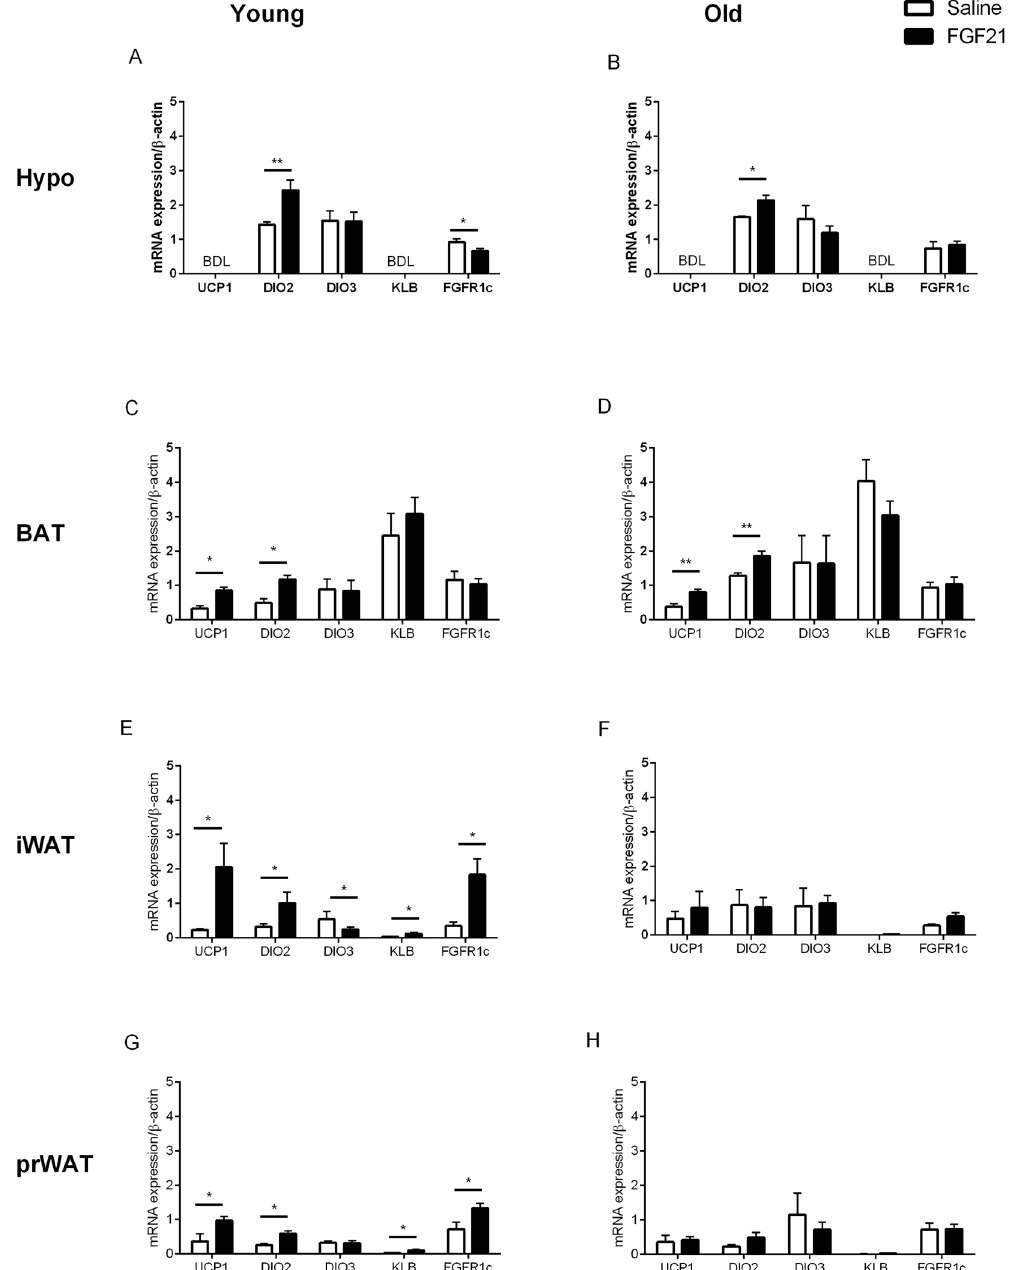
Figure 5. Treatment with FGF21 increases thermogenic genes in the hypothalamus and iBAT in young and aged Siberian hamsters, whilst the effects of treatment are lost in iWAT and prWAT in the aged Siberian hamster. Hypothalamus ( A and B ), iBAT ( C and D ), iWAT ( E and F ) and prWAT ( G and H ) gene expression profiles in young and aged Siberian hamsters treated with FGF21. Values are group mean ± SEM, n = 5–6 per treatment: * p < 0.05, ** p <